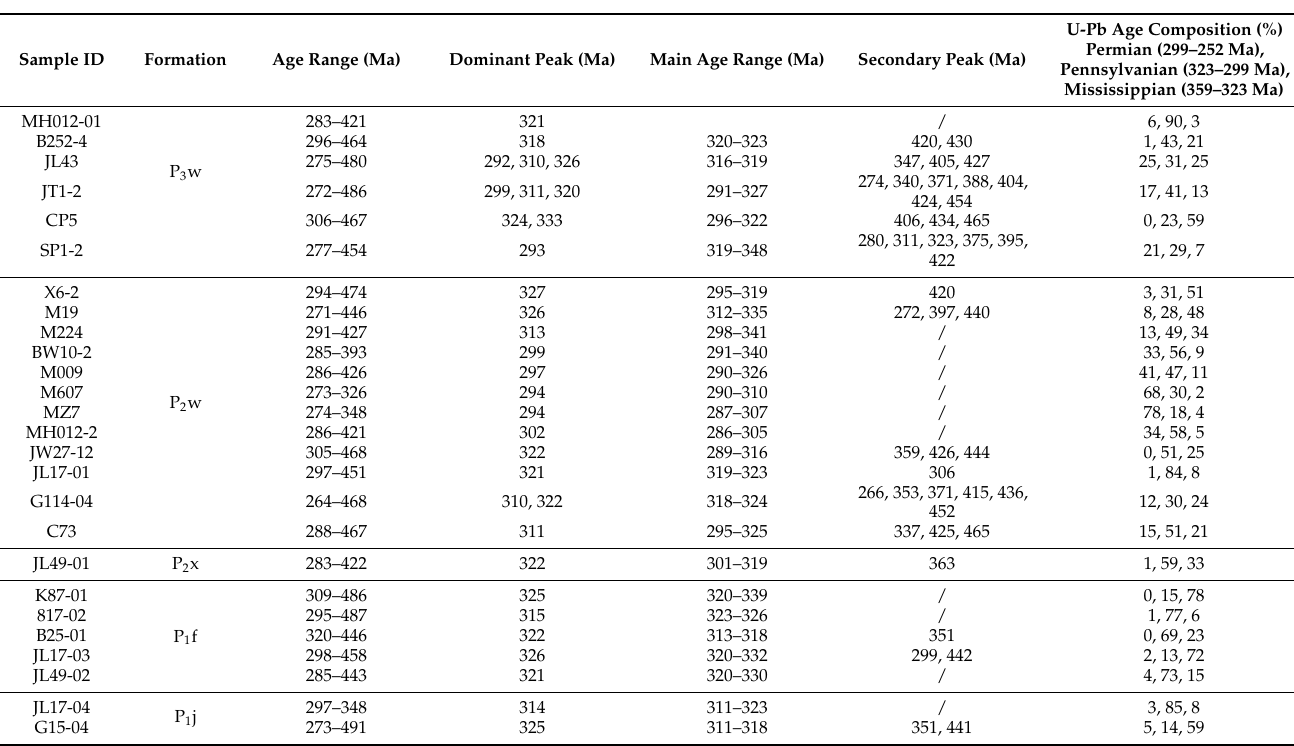
Table 2. Characteristics of the U-Pb ages of detrital zircons in the Mahu-Zhongguai area on the northwestern margin of the Junggar